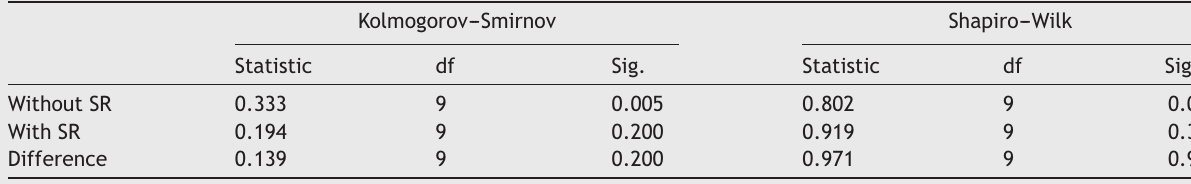
Results of testing the sample normality.